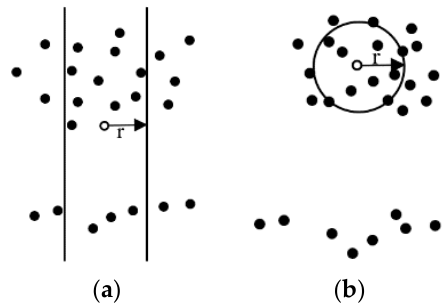
Figure 5. Neighborhood types used in feature extraction: ( a ) Cylinder neighborhood C , ( b ) spherical neighborhood S ( hollow point: Center point, r: Neighborhood radius ).